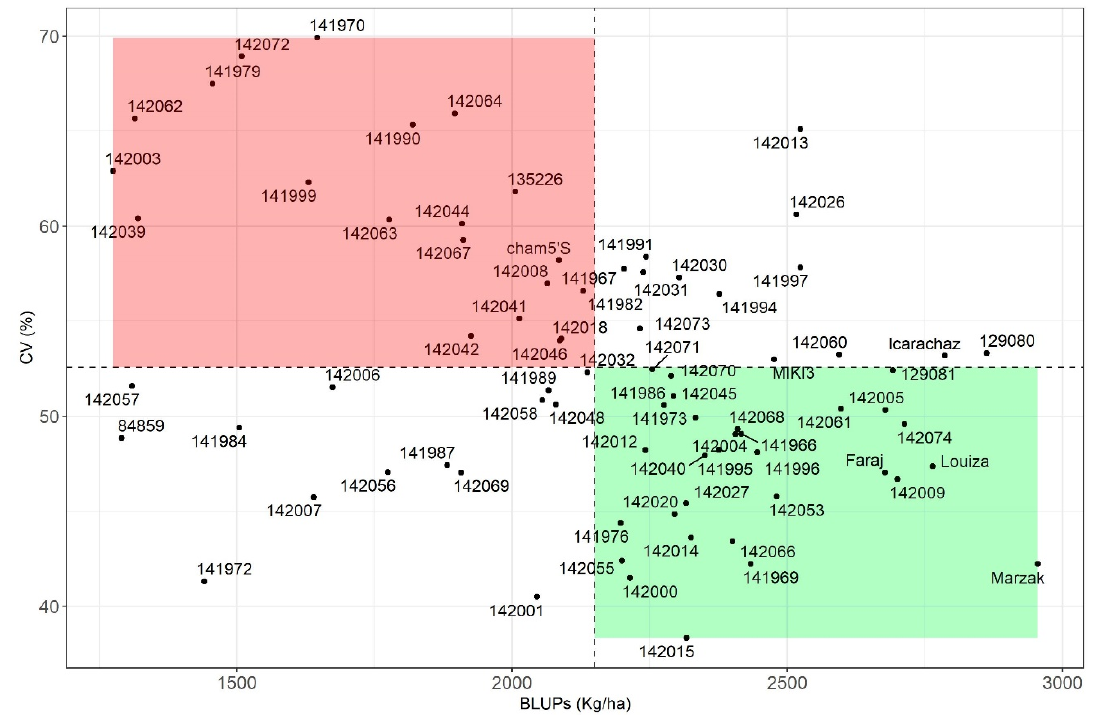
Figure 5. Plot of Best linear unbiased predictions (BLUPs) for grain yield plotted against Francis and Kannenberg (1978) coefficient of variation (CV). The red area highlights the undesirable genotypes while the green area highlights the stable and desirable genotypes. Vertical and horizontal dashed lines represent the mean of BLUPs and CV, respectively. Some labels were repelled using black arrows to avoid overlapping.